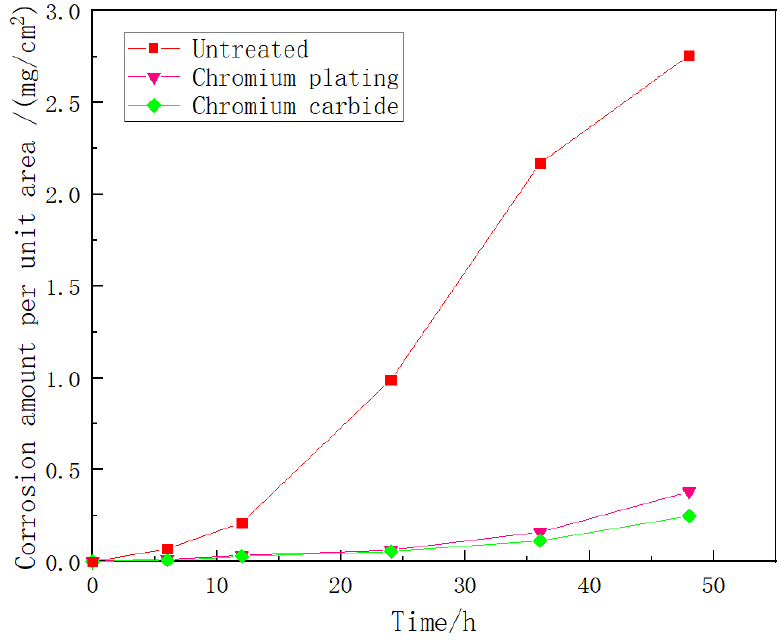
Figure 6. The relationship between the corrosion amount and time of three groups of specimens.